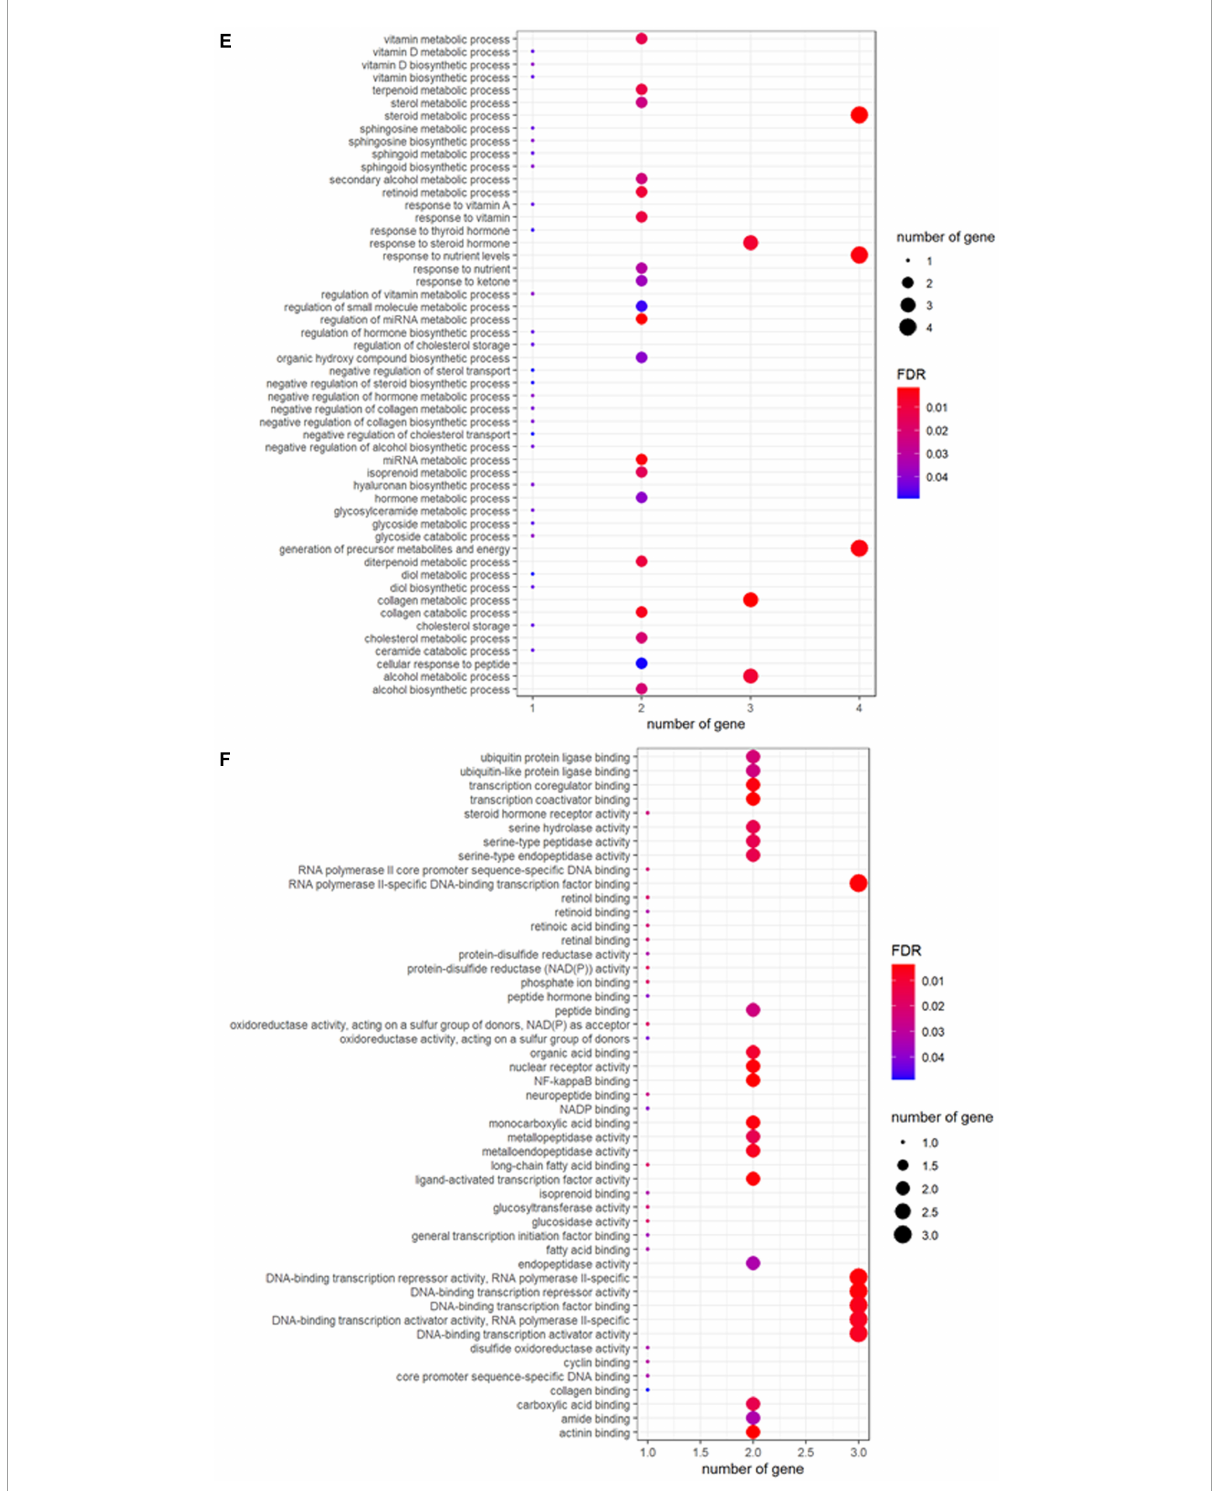
FIGURE1 Identification and functional characterization of fucoidan’s targets against perfluorooctanoic acid (PFOA)-associated obesity through the regulation of endoplasmic reticulum stress. (A) A Venn diagram showed the number of shared fucoidan-, PFOA-induced obesity-, and endoplasmic reticulum stress-associated genes (left panel). The Protein–protein interaction of the ten core targets was analyzed by using STRING (right panel). Gene ontology enrichment analysis showed the involvement of fucoidan’s targets in biological processes related to (B) lipid and fat metabolisms, (C) oxidative stress and inflammatory responses, (D) cell proliferation and differentiation, (E) metabolisms and biosynthesis, and (F) molecular functions related to fat synthesis. The size of the bubble represented the number of involved genes and the color of the bubble represented the significance of the